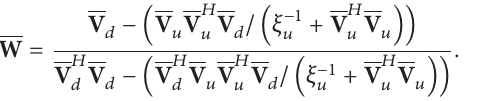
Figure 6: Effect of the angular mismatch between the distortionless constraint direction and the real direction of the desired signal at 𝑀 = 6 .